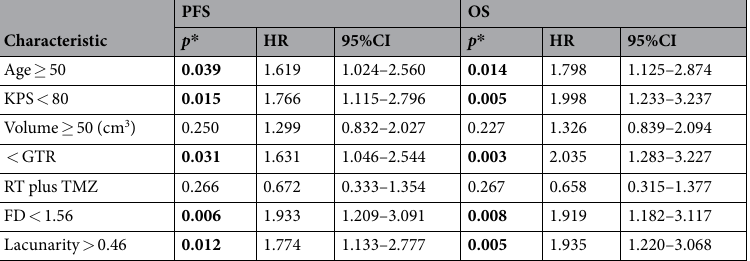
Table 2. Univariate Cox analysis for factors potentially influence survival outcomes. Abbreviations: CI, confidence interval; HR, hazard ratio; RT, radiotherapy; TMZ, temozolomide; * without Bonferroni correction.